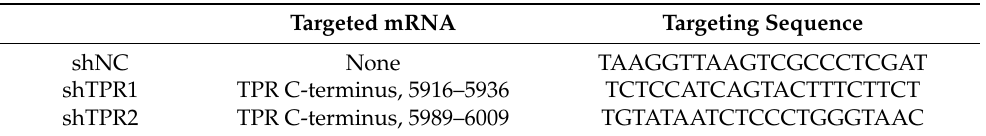
Table 1. Tpr sequences targeted by the